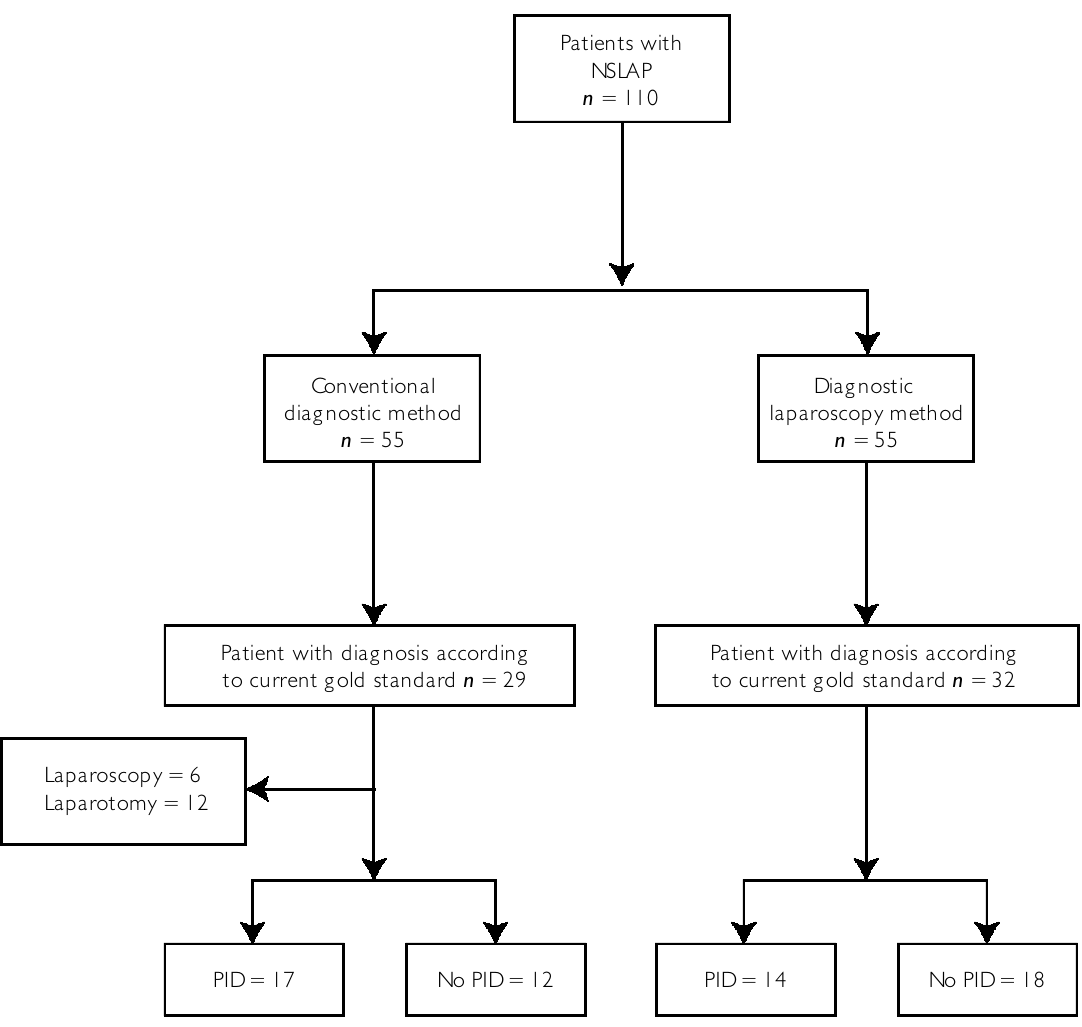
Figure 1 Flow chart of patients with non-specific lower abdominal pain (NSLAP). PID, pelvic inflammatory